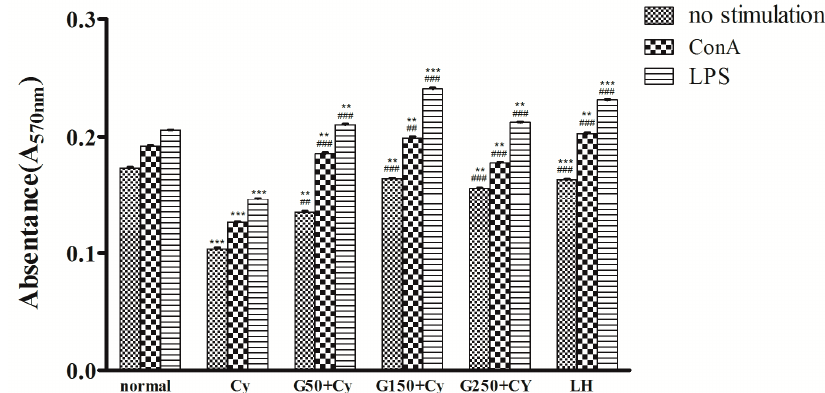
Figure 4. Effect of GPMPP on concanavalin A or lipopolysaccharide-induced lymphocyte proliferation in Cy-immunosuppressed mice. ** p < 0.01, *** p < 0.001, compared with normal control. ## p < 0.01, ### p < 0.001, compared with model control. Values are means ± SD, n = 10.